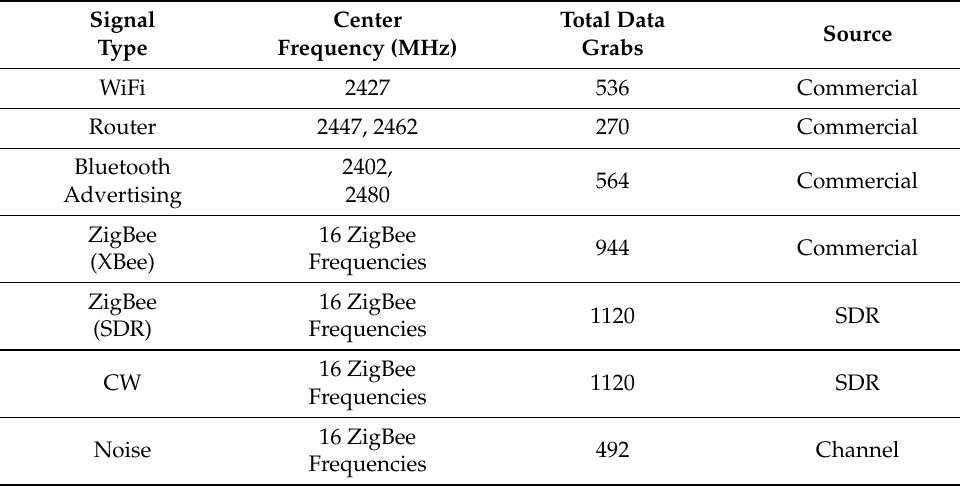
Table 1. Summary of Collected Data—Model Development.